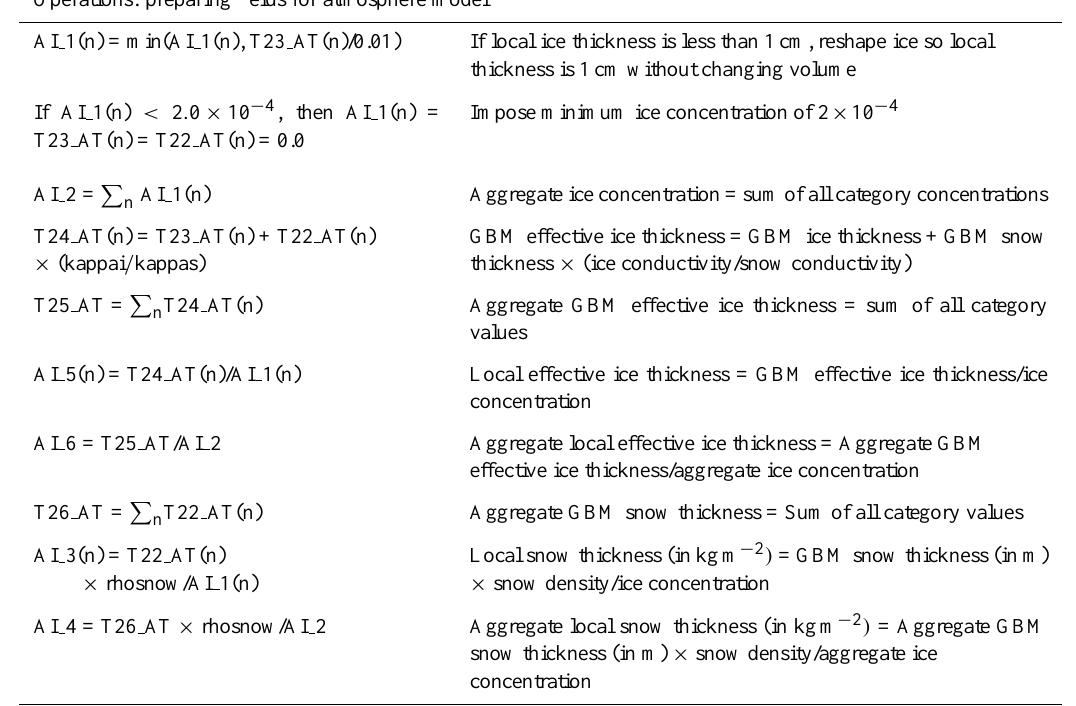
Table 2e. Details of preparing the fields for the atmosphere model in Fig. 5. These manipulations are in the UM subroutine OASIS3 GETA20 . “n” is the ice thickness category index.